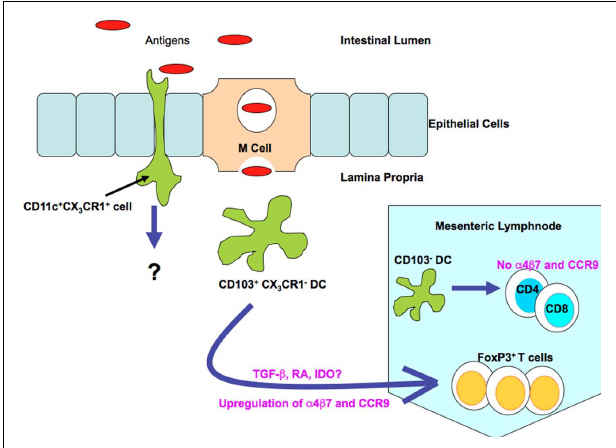
FIGURE 2 | Mechanisms of antigen sampling by lamina propria DC populations under steady state conditions. DCs can capture antigenic material (including bacteria and other antigens) from the luminal compartment via direct transport through the M cell. CX 3 CR1 + cells can samples antigens directly by extending their dendrites into the luminal compartment.This is achieved due to the ability of the CX 3 CR1 + cell population to open the tight junctions between epithelial cells. CD103 + CX 3 CR1 − DCs actively migrate to the mesenteric lymph nodes under steady state conditions; these cells are responsible for the induction of antigen-specificTreg cells. Moreover these cells are also responsible for the induction of gut homing phenotypic changes, such as up regulation of CCR9 and α 4 β 7 on T cells. Antigens can also be captured by the underlying immune cells via breaches in epithelial integrity (not shown) and by direct transport via the fetal Fc receptor (not